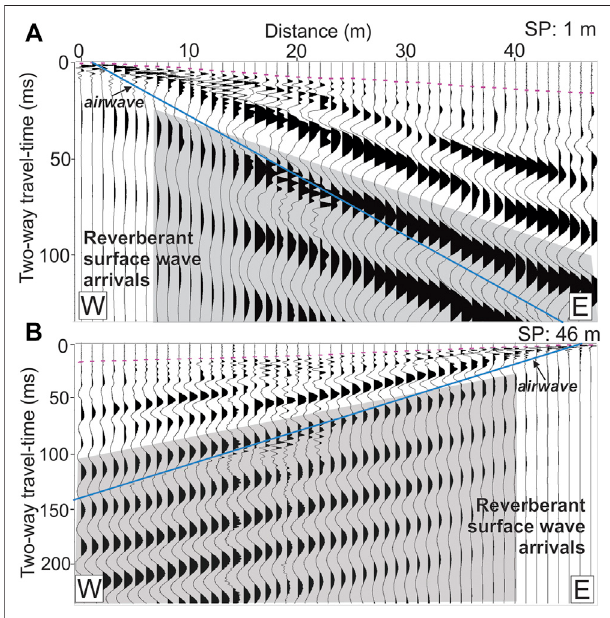
FIGURE 6 | First 150 ms TWT of seismic gathers acquired at the TerminalMoraineSite,displayedinpositivestandardpolarity (A) Forwardshot fromshotlocationS1and (B) reverseshotfromshotlocationS46.First-break picks marked by blue dashes and reverberant surface wave arrivals (potentially guided waves) highlighted in